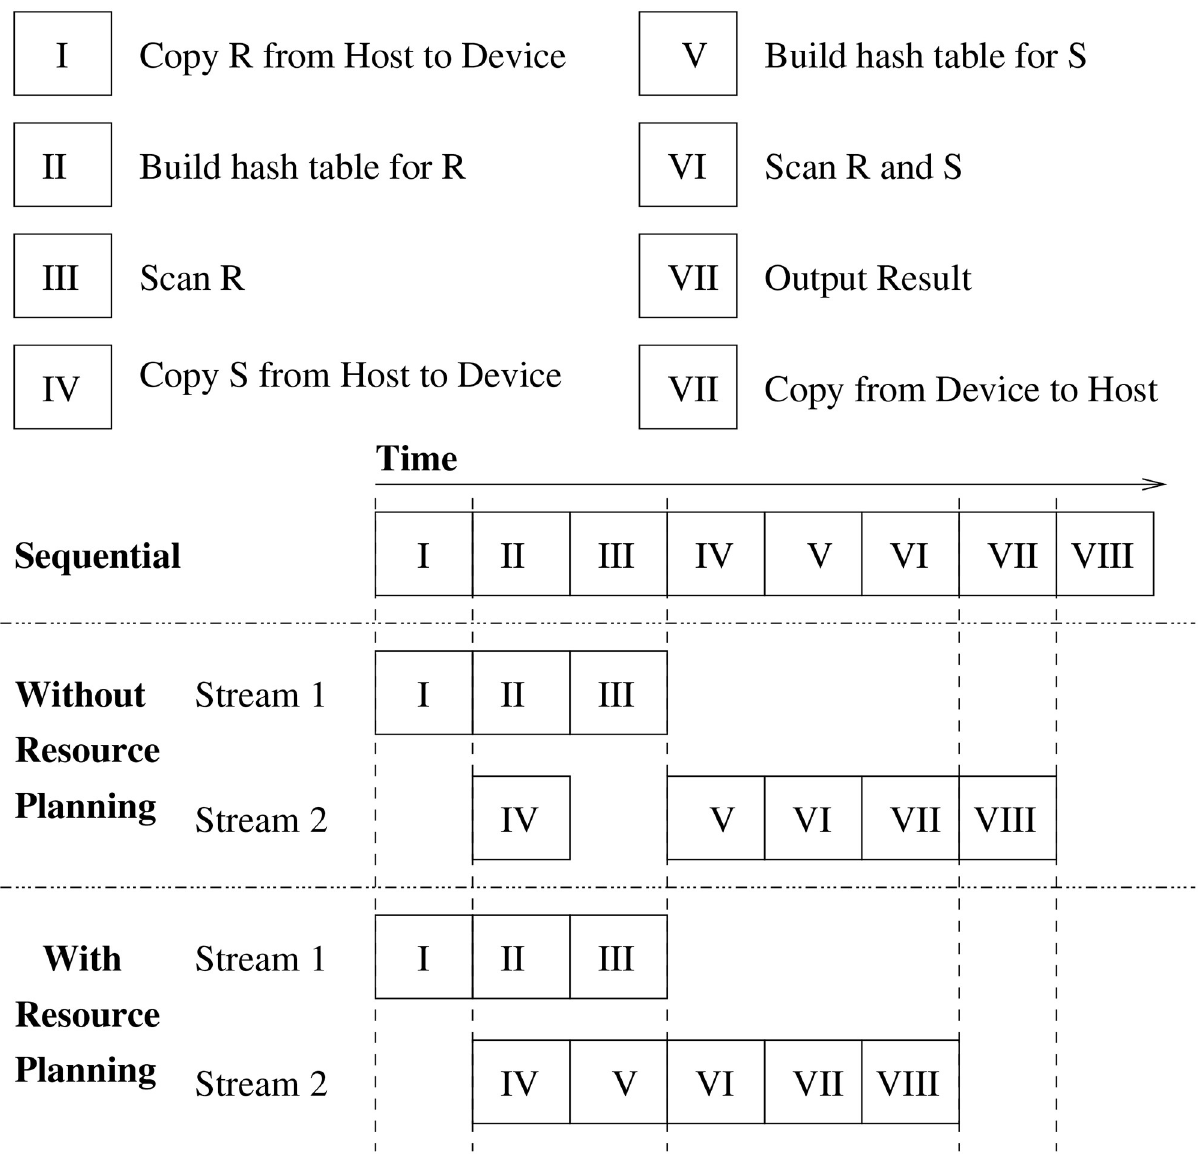
Fig 3. Three different schedules for launching kernels in a hash join between tables R and